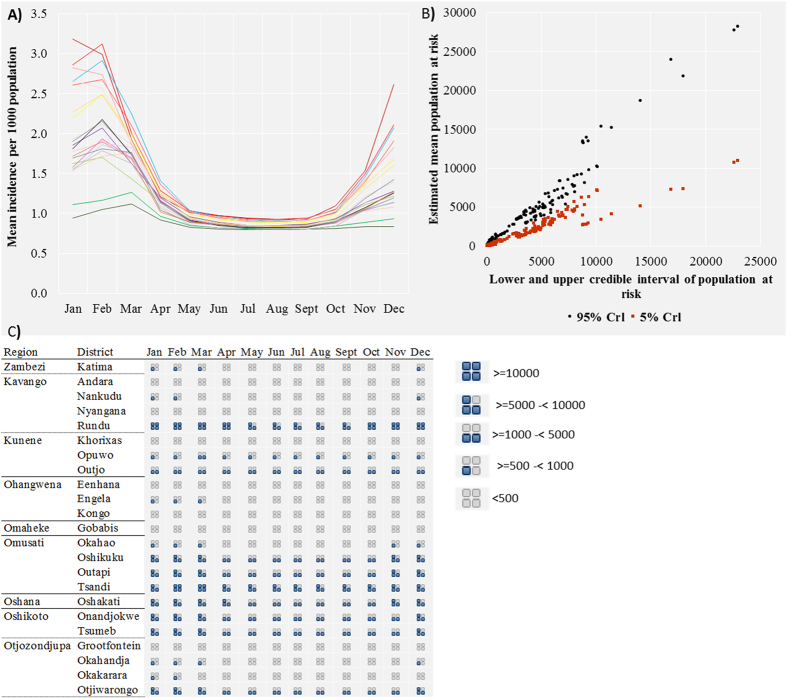
(A) The modelled seasonal pattern of incidence of P. falciparum per 1000 population by month in 22 northern districts in Namibia. Modelling results suggest that incidence varied by district and month, but was lowest between May and October. (B) Scatterplot showing the estimated mean population at risk of P. falciparum malaria in Namibia in 2014 and the Bayesian credible intervals based on predicted incidence by district and month. The credible intervals (Crl: Bayesian credible interval) were wider where the estimated mean population at risk was more than 10000 but closer to the mean where population at risk was <10000. (C) The estimated population at risk of P. falciparum malaria in Namibia in 2014 by district and month. Population estimates are based on the worldpop dataset (http://www.worldpop.org.uk/) for Namibia. P. falciparum incidence estimates were modelled in a Bayesian framework from assembled malaria cases between 2012 and 2014 and incorporating space-time covariates.